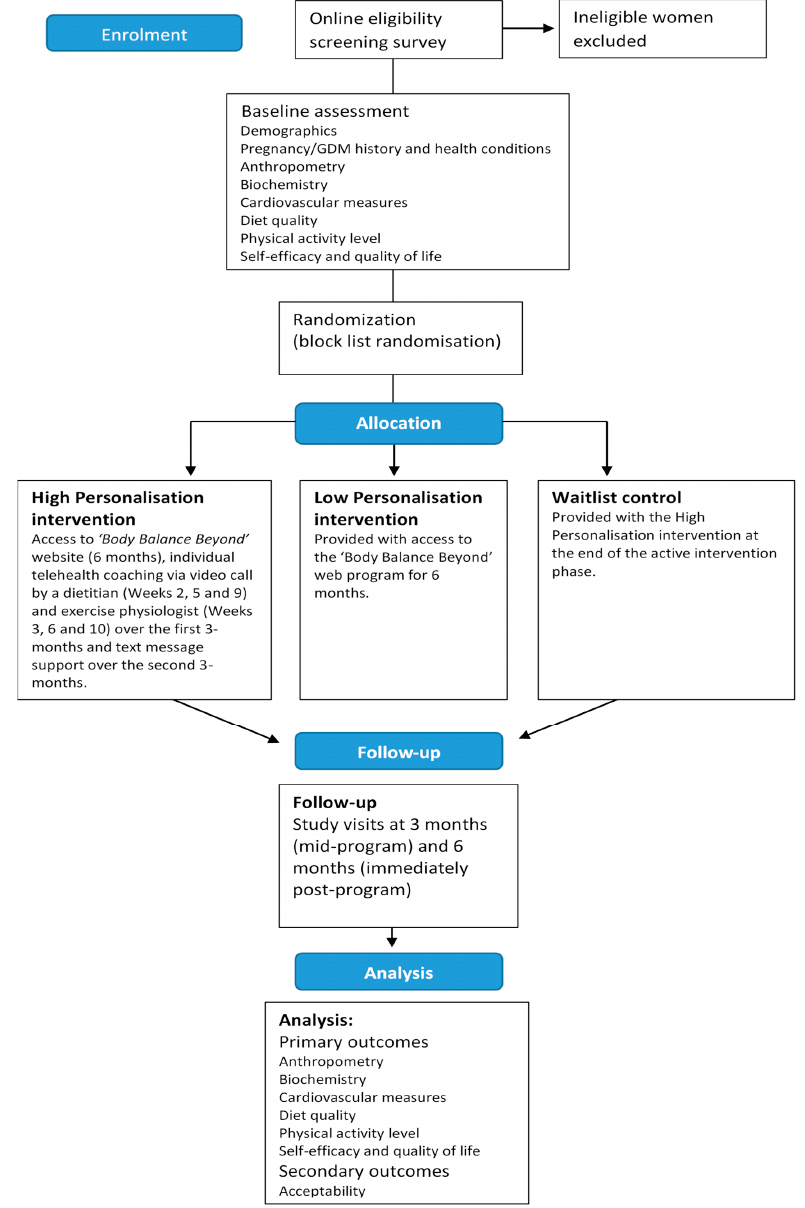
Figure 1. Study protocol for a 6-month pilot randomised controlled trial for women with recent gestational diabetes mellitus (GDM) who were at risk of developing Type 2 diabetes mellitus (T2DM).